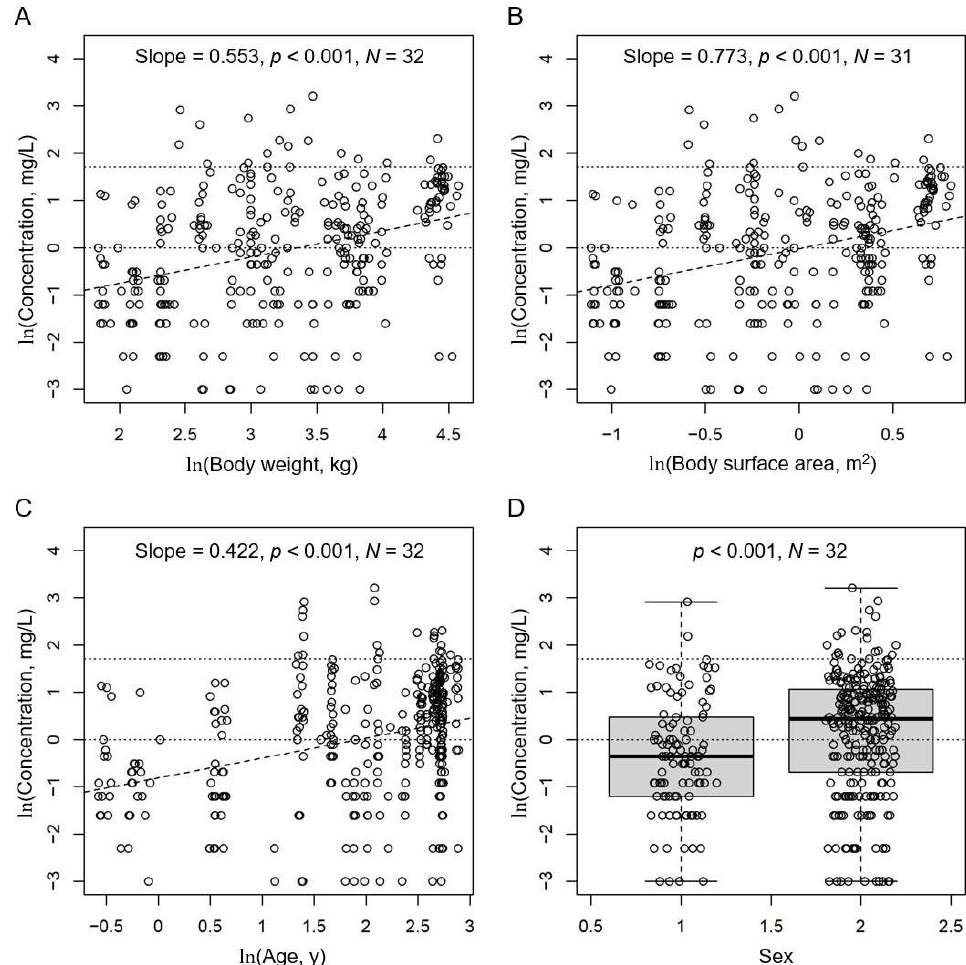
Figure 3. ln( C trough ) correlated with ( A ) ln(body weight), ( B ) ln(body surface area), ( C ) ln(age), and, ( D ) differed significantly between female (f) and male (m) patients. The linear regressions of the correlations in ( A – C ) are indicated as broken line and slope with its level of p . p of a two-tailed homoscedastic t-test in ( D ). Horizontal dotted lines indicate the recommended range for C trough (1 to 5.5 mg/L). N , numbers of patients with available data and included in the plot.